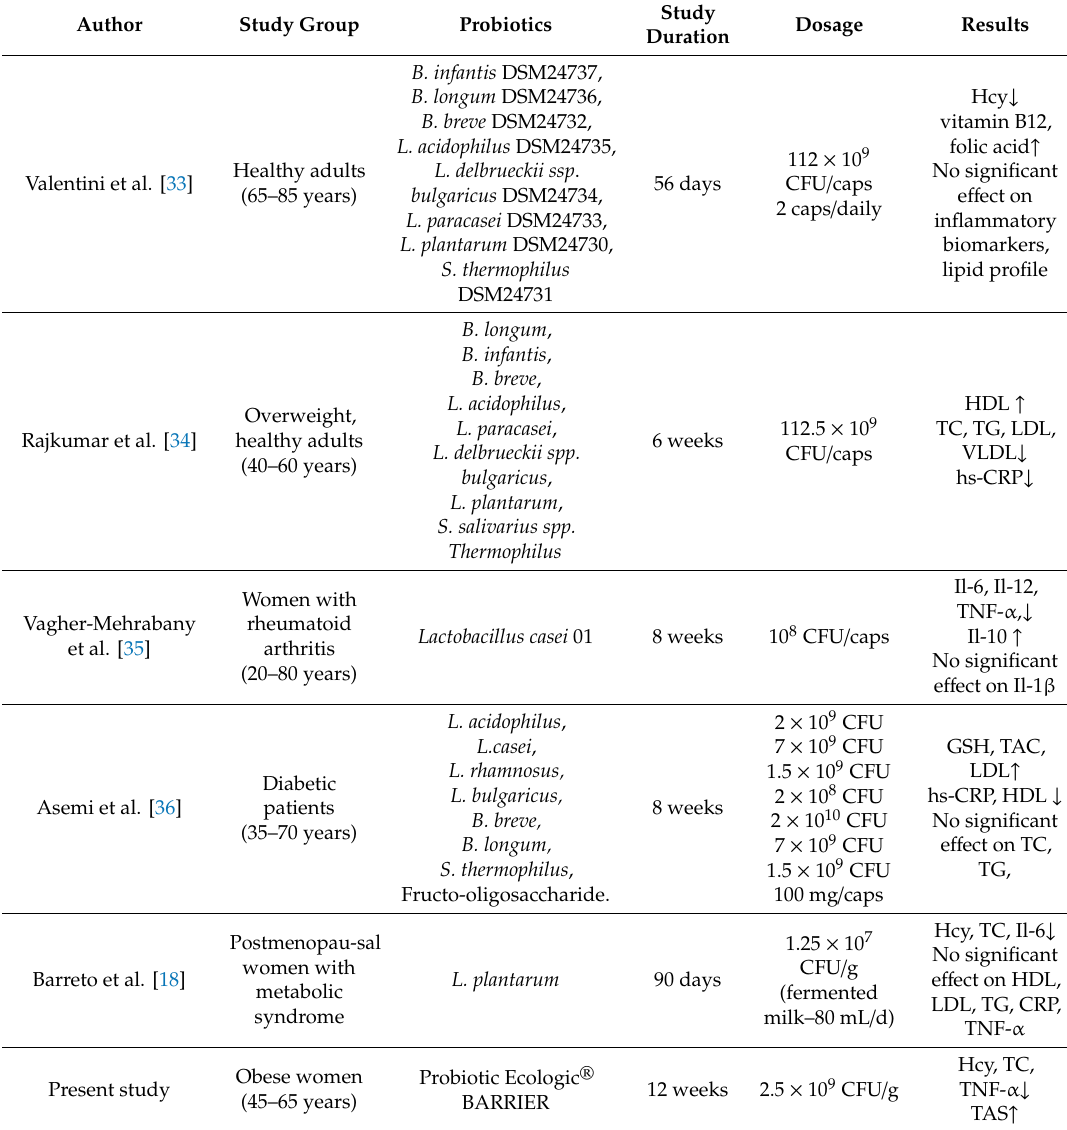
Table 6. Summary of studies analyzing the e ff ect of probiotic supplementation on Hcy levels, lipid profile, oxidative stress and inflammation